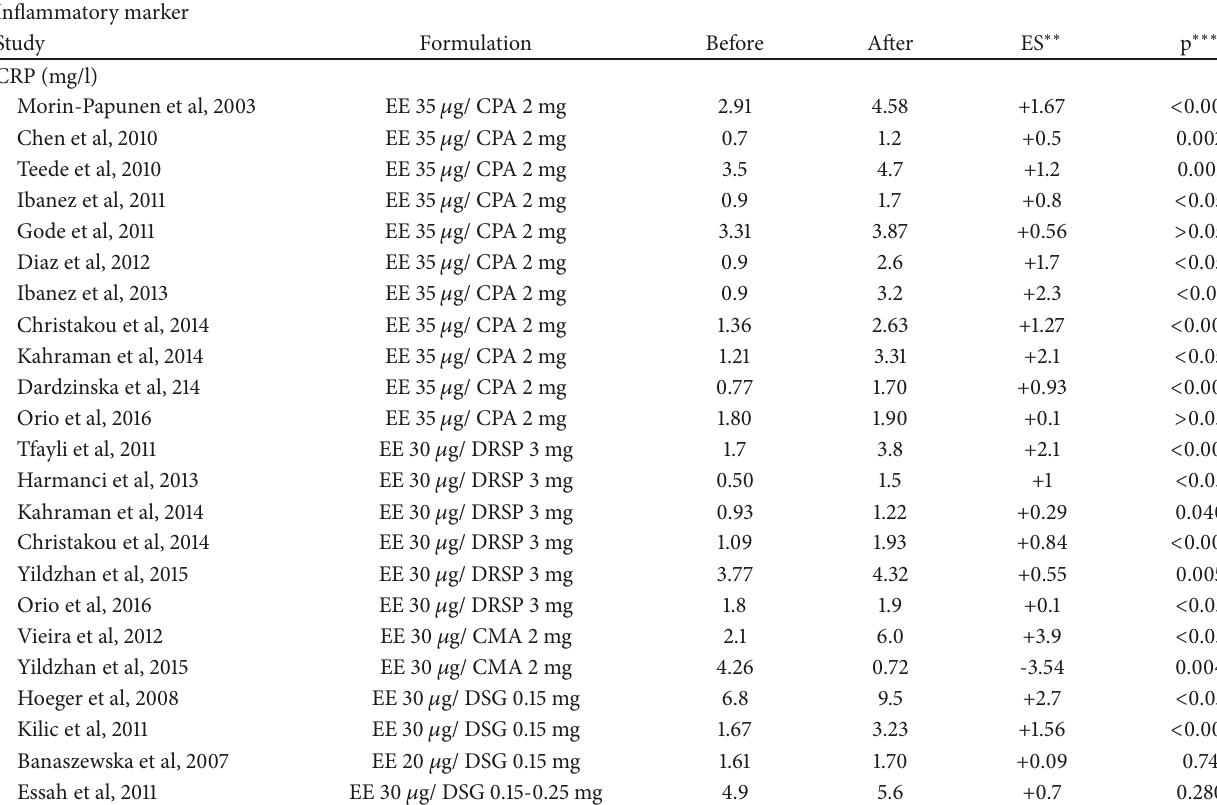
Table 3: Summary of the influence of different oral contraceptive combination on C-reactive protein in polycystic ovary syndrome ∗ . Inflammatory